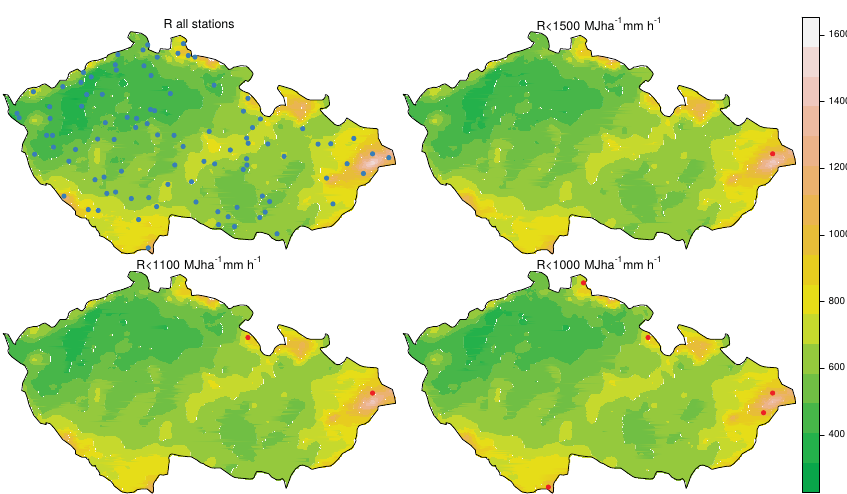
Figure 3. R factor estimated with the GLS E model using all available stations (top left panel) and the GLS E model fitted considering only sta- tions with an R factor below 1500MJha − 1 mmh − 1 (top right panel), 1100MJha − 1 mmh − 1 (bottom left panel), and 1000MJha − 1 mmh − 1 (bottom right panel). Blue points in the top left panel indicate the full set of 96 stations; red dots in the other panels correspond to stations excluded from the fitting procedure.